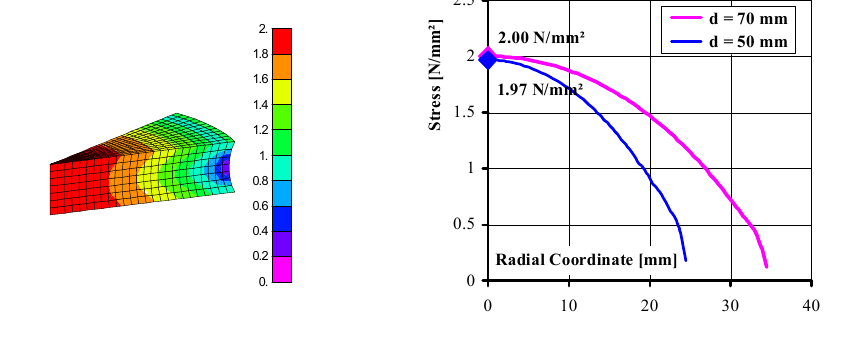
Figure 6: Maximum principal stresses of the point support model loaded by approx. 1700 N.